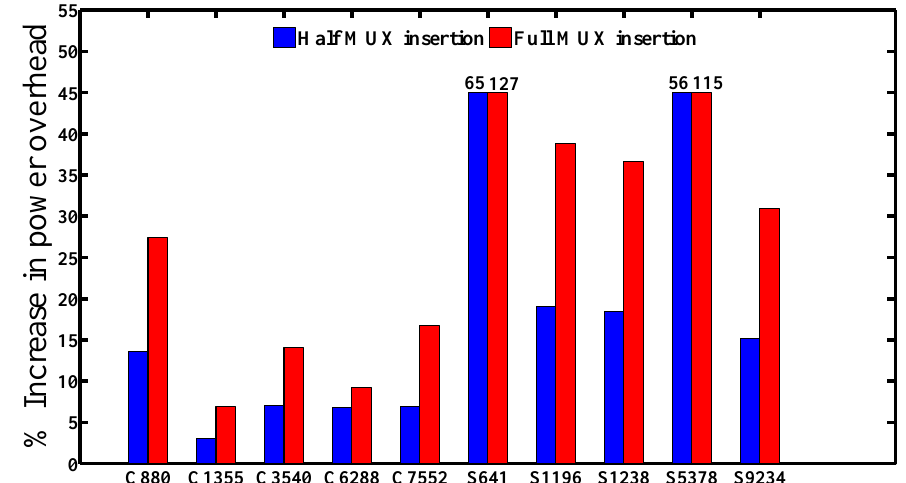
Figure 11. Comparing the power overhead of full and half MUX insertions for logic